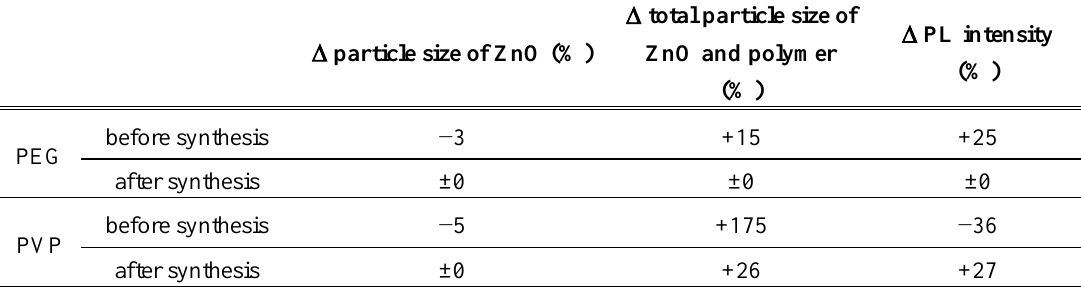
Table 1. Change in size and PL intensity of capped ZnO nanoparticle (The values with addition of polymer were compared to the value without addition of polymer).